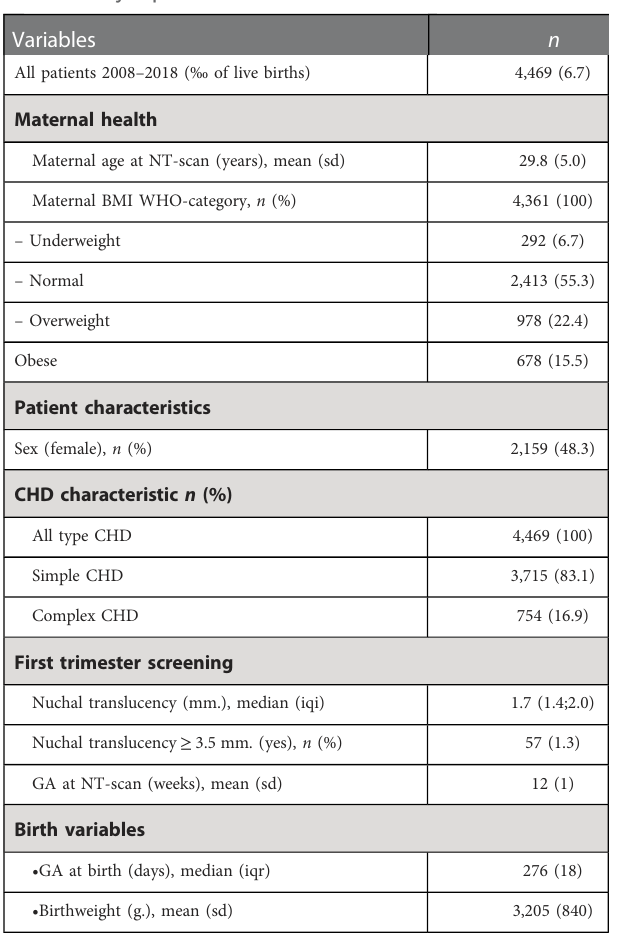
TABLE 1 Study Population characteristics.